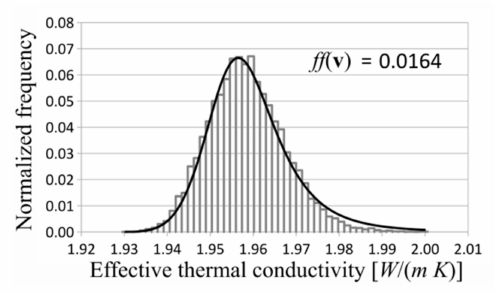
Figure 6. Histogram and log-logistic distribution.